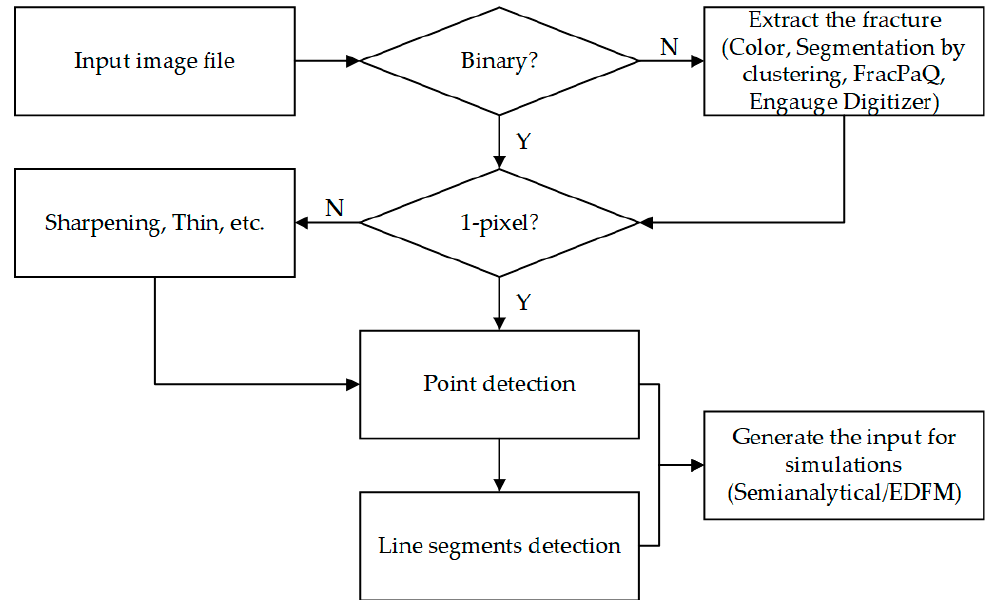
Figure 3. A flow diagram of the fracture detection algorithm. With the input of an image file with the traced fracture network, a text file will be the output, which can be used as the input file for the semianalytical/EDFM simulation.